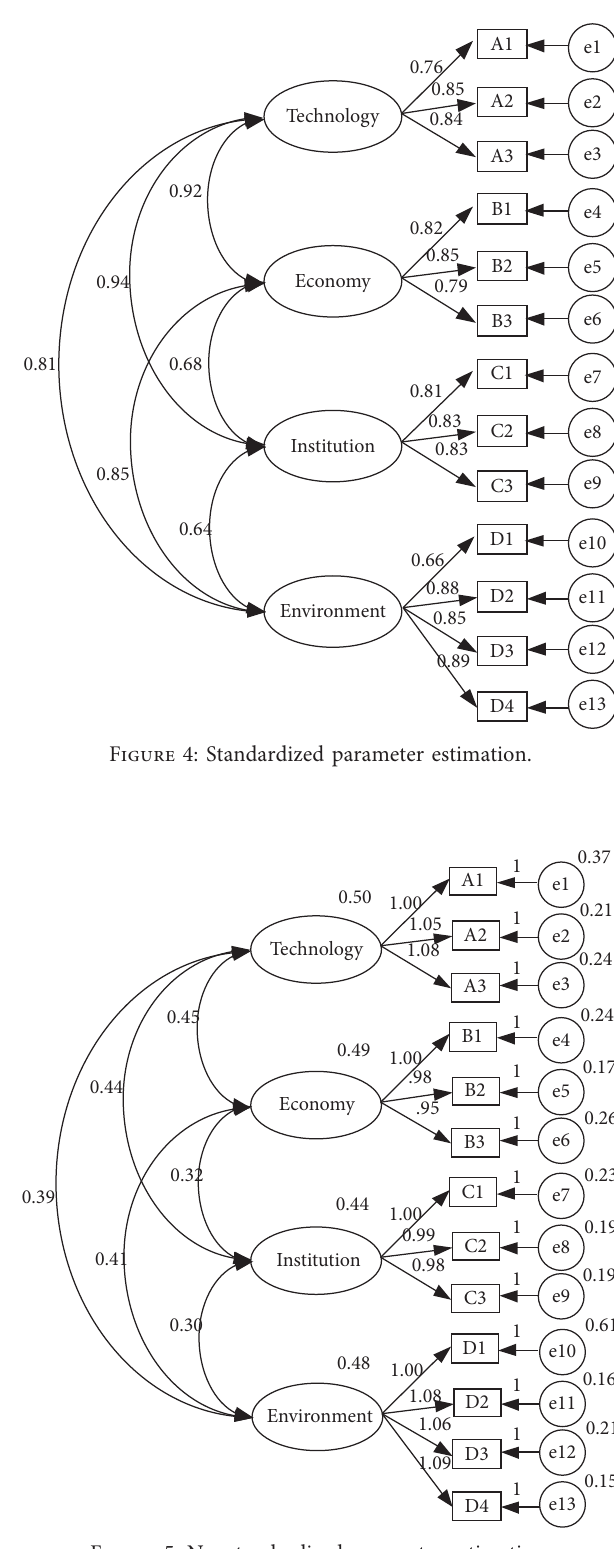
Figure 5: Nonstandardized parameter (i) Factor 1: technology. On the basis of the factor loading, the influencing factors are ranked from high to low: production efficiency (A2), quality of